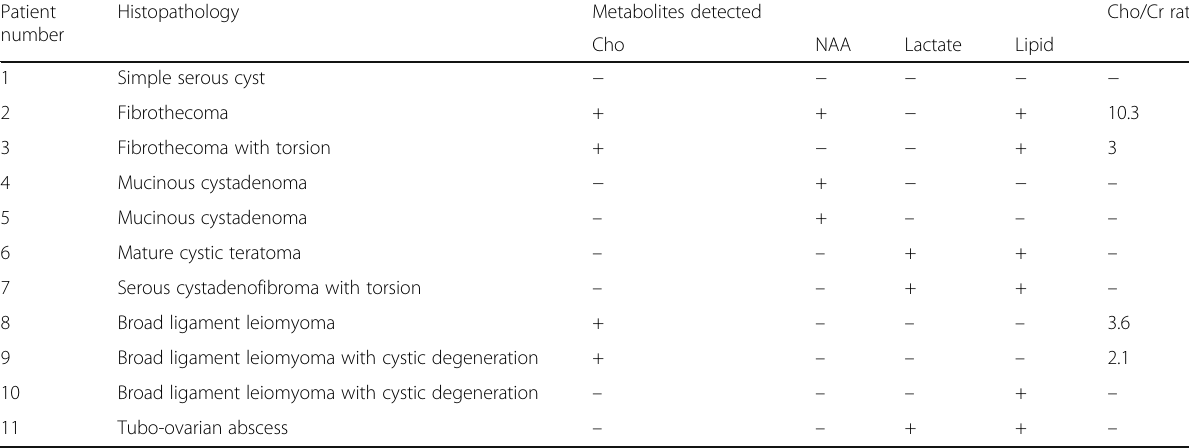
Table 2 Metabolite levels in 11 benign cases Patient